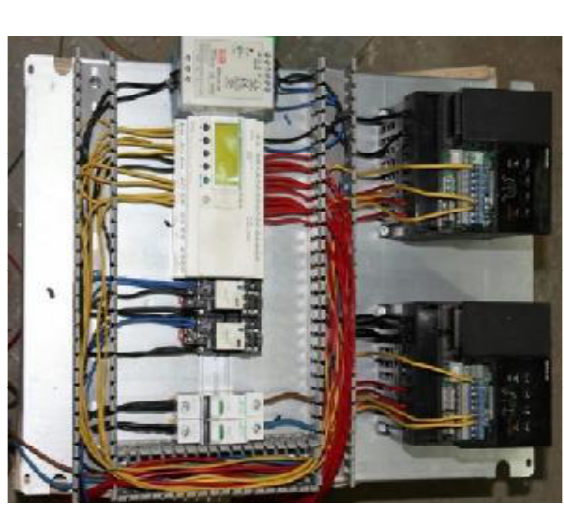
Fig. 9. The Programming of Zelio.